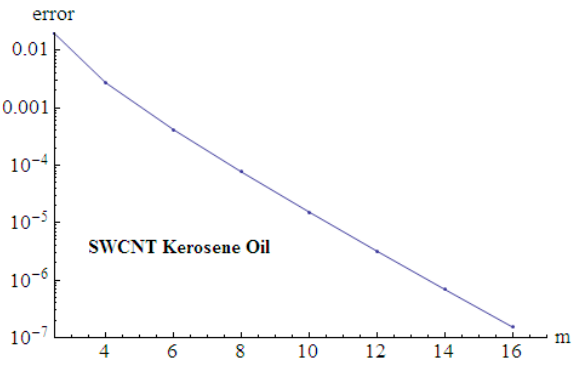
Figure 2. Total error vs. order of approximations.